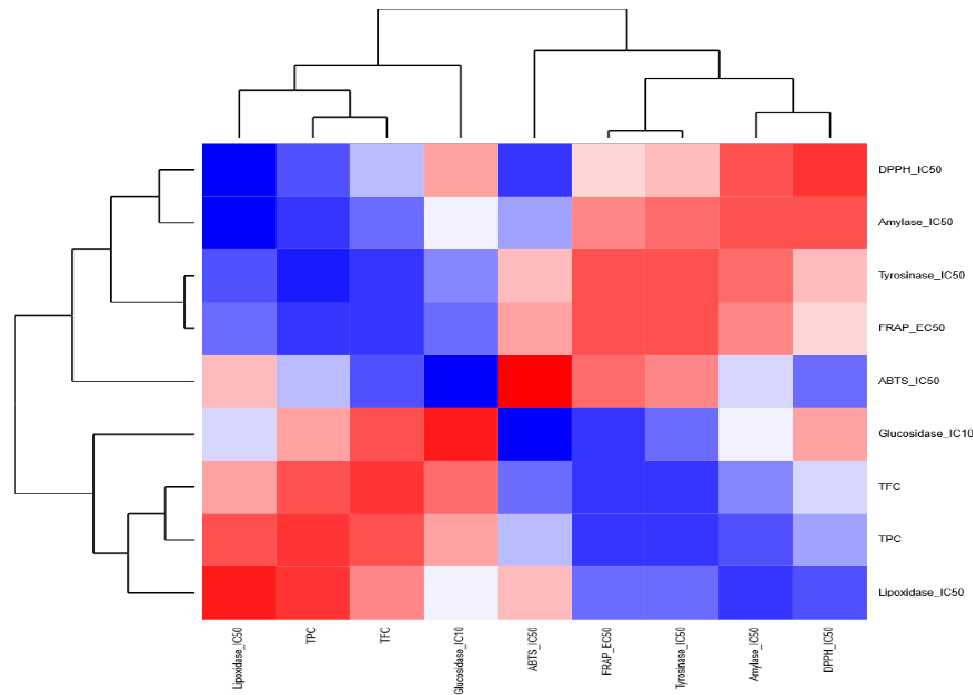
Figure 9. Heatmap highlighting the relationships among the chemical screenings within the meth- anolic extract of leaves.